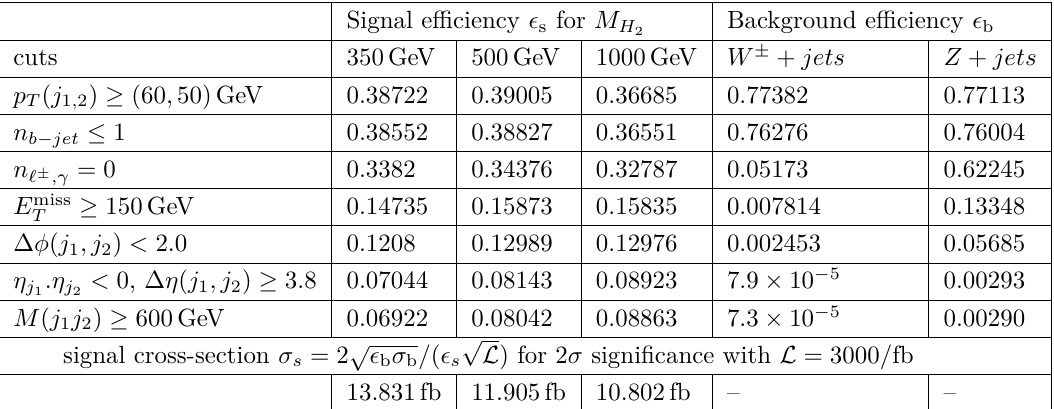
– Table 5 . Cumulative cut efficiencies for Signal: pp → H 2 jj → 2 j + MET and the SM background: W + jets and Z + jets . The numbers in last row are the required signal cross-sections to obtain 2 σ significance using 3000 / fb luminosity. 2σ 5σ